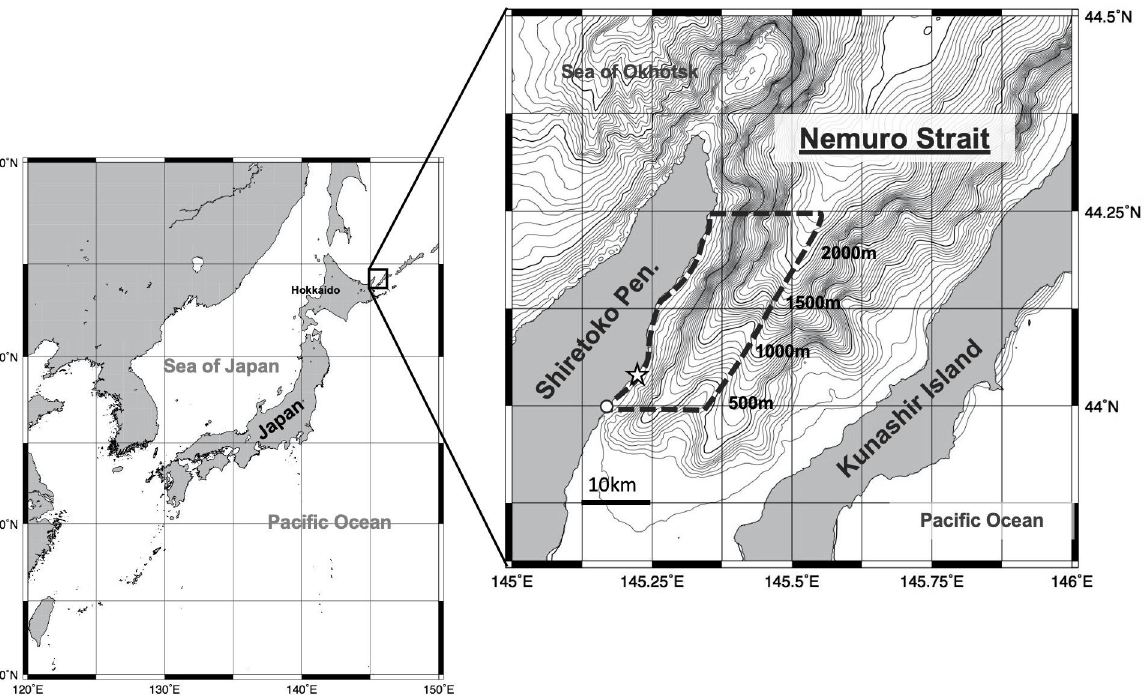
Fig 1. Map of the location of Nemuro Strait, Hokkaido, Japan. Broken line shows the range of study area, and open circles indicates position of “Rausu Fishing Port” (departure point of whale-watching boat). Open star shows the “Whale View Park” (theodolite station, see S1 Fig). The maps were created by using GMT: The Generic Mapping Tools (ver. 5.4.5; https://www.generic-mapping-tools.org/, Wessel et al. 2013 [55]), and the depth contours were created on GMT based on “500m Gridded Bathymetry Data" provided by Japan Coast Guard (Japan Oceanographic Data Center (JODC) 500m Gridded Bathymetry Data: https://jdoss1.jodc.go.jp/vpage/depth500_file.html).